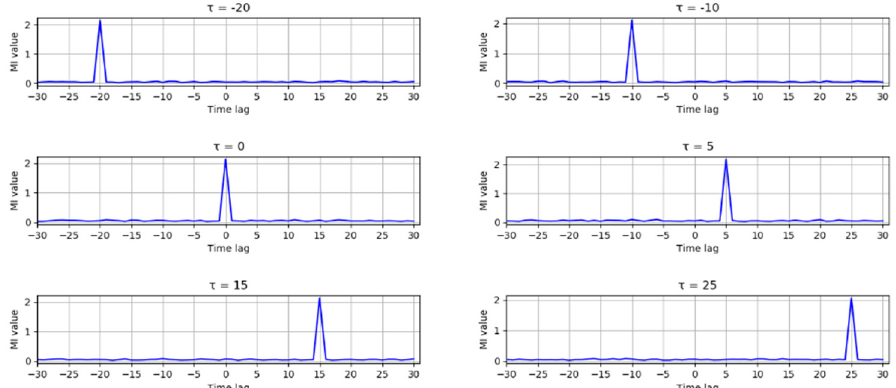
Figure 1. Time delay detection results.